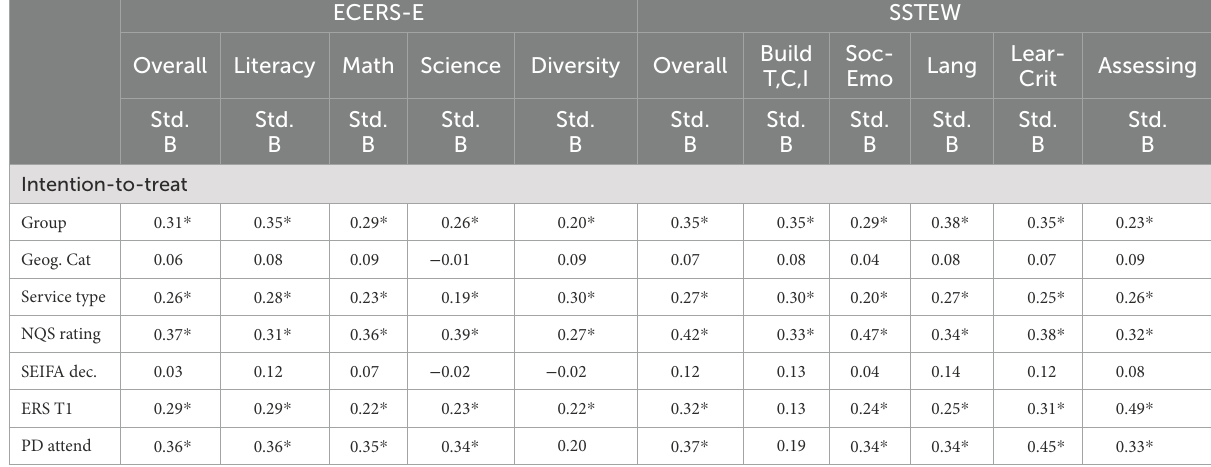
TABLE 4 Standardised beta weights for predictors of post-intervention ECERS-E and SSTEW ratings,